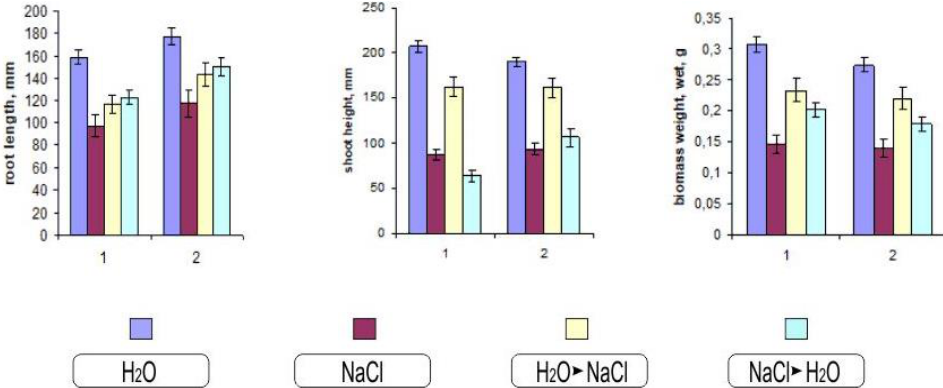
Figure 3. Effect of salinization on biometric characteristics of durum and soft wheat 10-day-old seedlings during salinization. 1—Orenburgskaya 10; 2—Orenburgskaya 22. The mean values (n = 30) and their standard deviations are shown according to Student's criterion, p < 0.05.